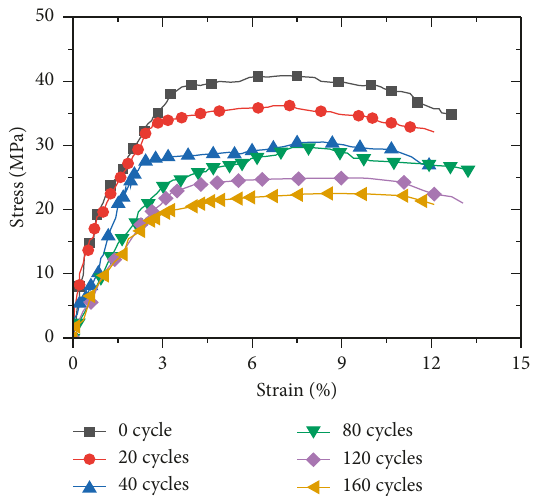
Figure 6: The relationship between stress and strain (the mixed solution of Na 2 SO 4 and NaCl, i.e., SE3 specimen).